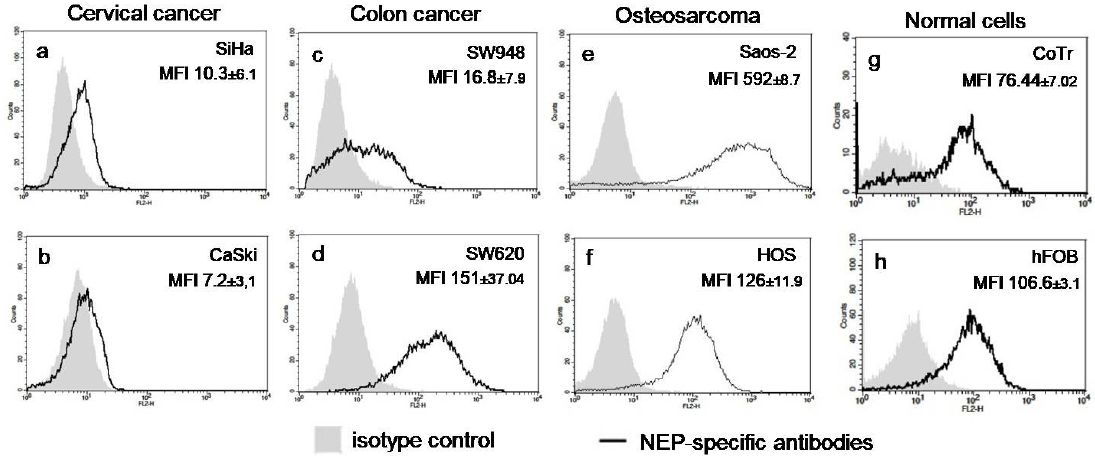
Figure 1. Expression of NEP at the protein level in primary (SiHa) (a) and metastatic (CaSki) (b) cervical cancer cells, primary (SW948) (c) and metastatic (SW620) (d) colon cancer cells, primary moderately (Saos-2) (e) and highly (HOS) (f) aggressive osteosarcoma cells, normal epithelial cells of the intestine (CoTr) (g), and normal osteoblasts (hFOB) (h). The level of NEP was quantified by means of flow cytometry after cell staining with the PE-conjugated mouse IgG1 isotype control and with PE-conjugated mouse anti-human NEP mAb IgG1. The level of NEP was expressed as Mean Fluorescence Intensity (MFI) ± SD of three independent experiments. The histograms shown are representative.